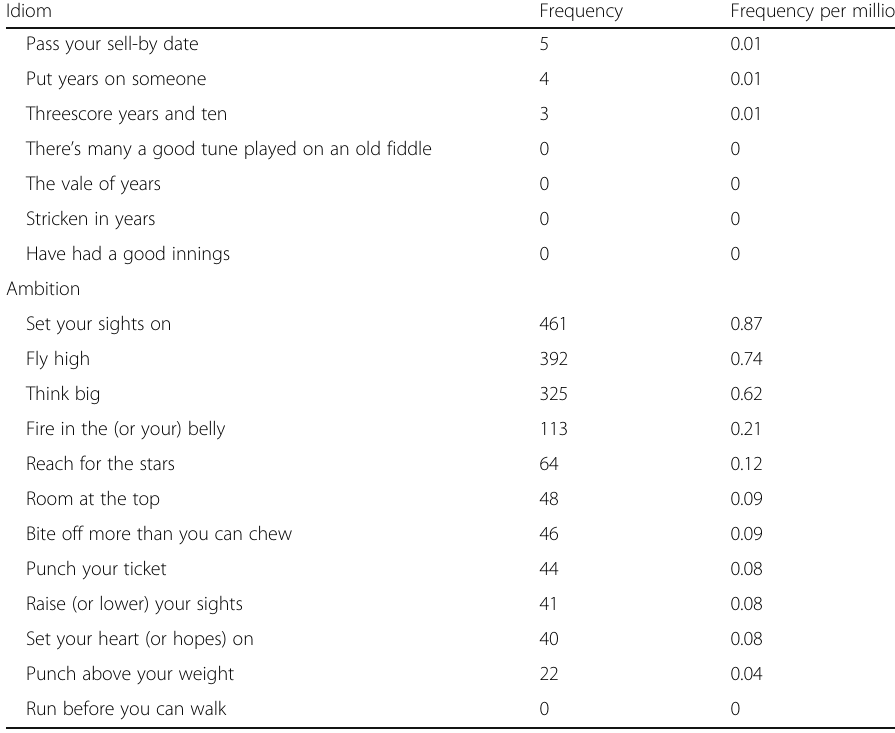
Table 5 Thematic index of Oxford Dictionary of Idioms along with the frequencies per million